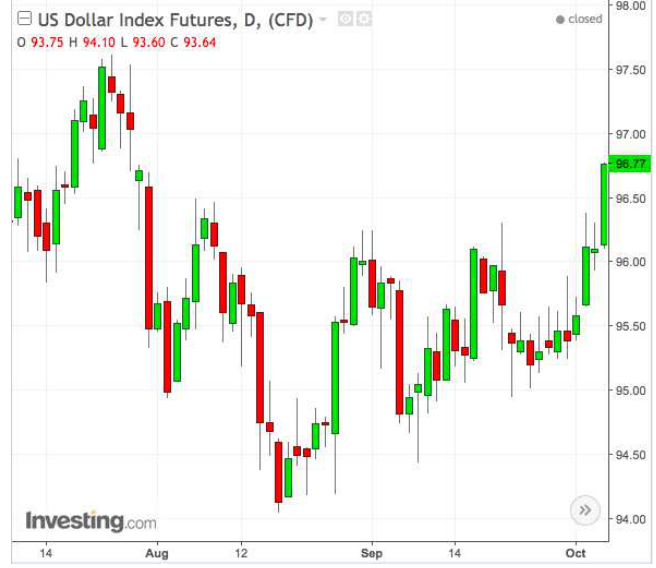
Figure 2. Dynamics of the dollar index at the beginning of October 2016